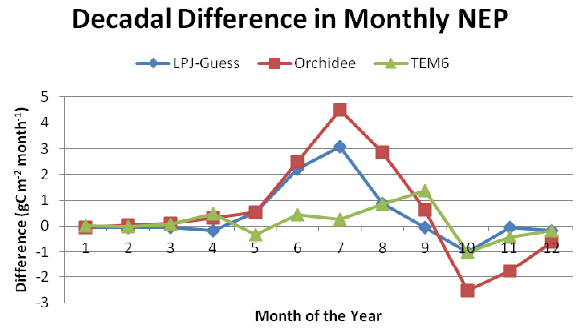
Fig. 4. Difference in mean monthly NEP between the 2000s (2000– 2006) and the 1990s (1990–1999) for LPJ-Guess WHyMe, Or- chidee, and TEM6.